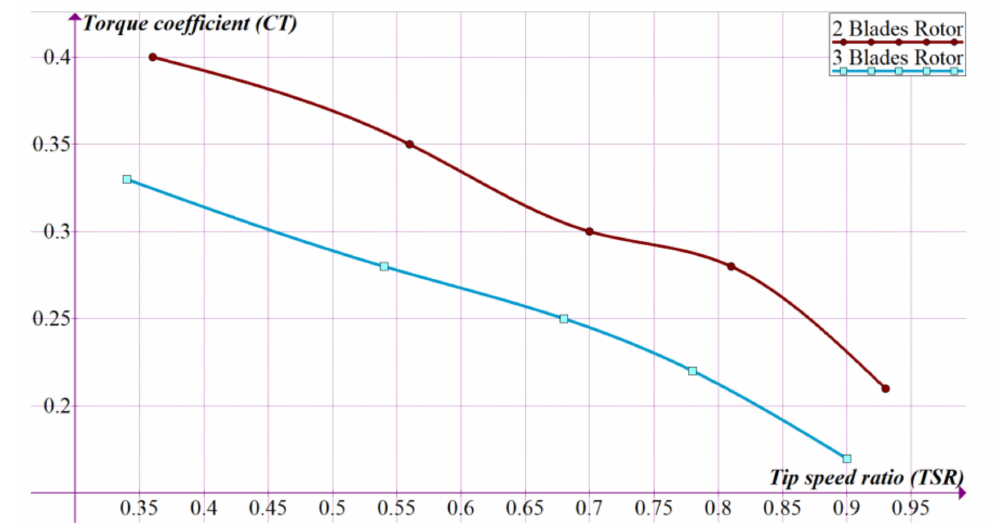
Figure 3. Torque coefficient (CT) for two- and three-blade rotors [66].